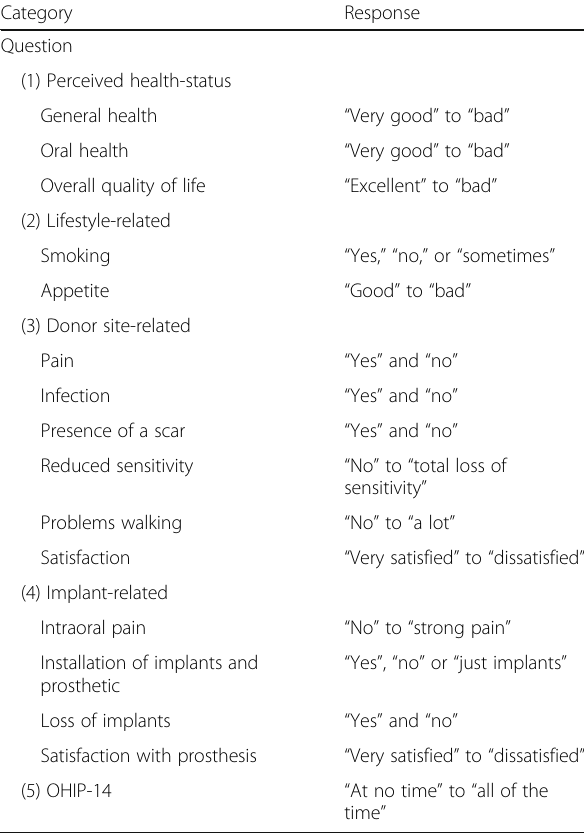
Table 1 Summary of